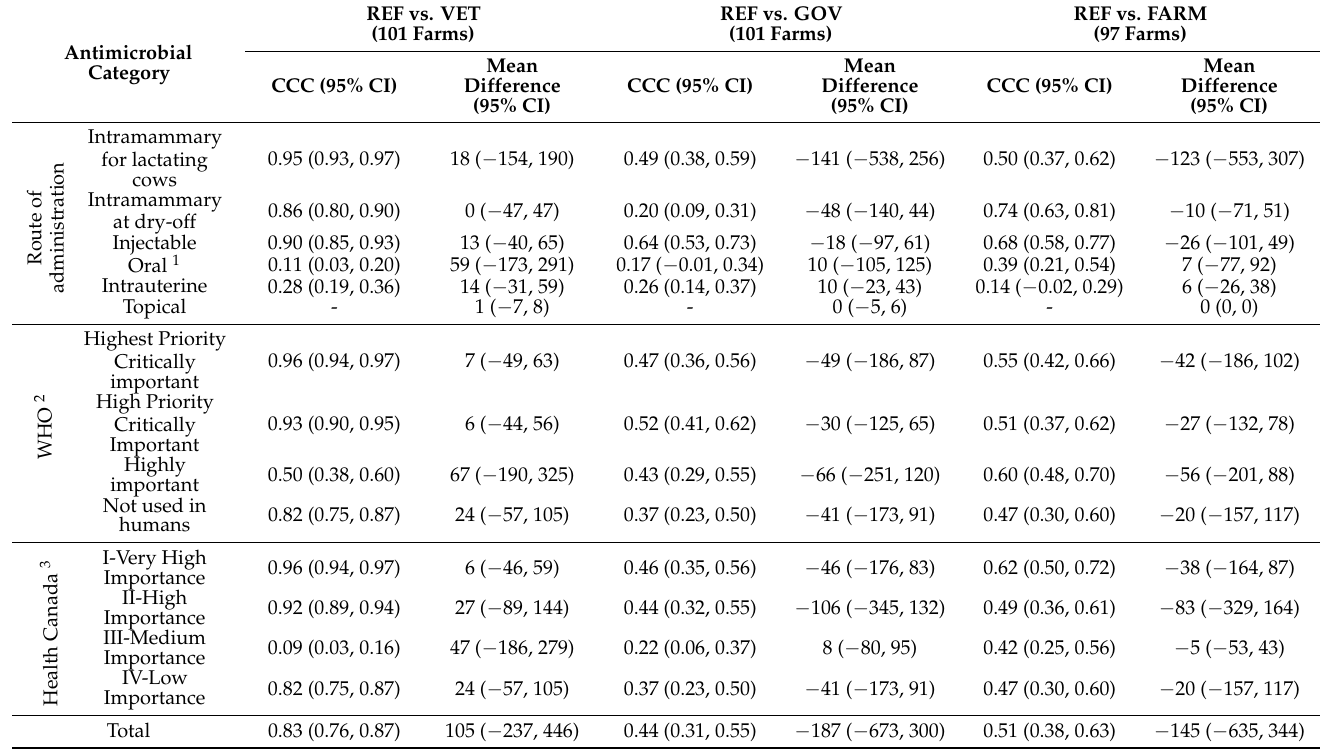
Table 2. Concordance correlation coefficients (CCC) with their 95% confidence interval (95% CI), and mean differences with their 95% CI, calculated from 101 or 97 dairy farms from Qu é bec, Canada, to report agreement between a garbage can audit (REF method) and veterinary invoices (VET method), a governmental database (GOV method), and farm treatment records (FARM method), for quantification of usage rate of antimicrobial agents from products other than medicated feed (in DCDbovCA/100 cow-years) by route of administration, by category according to the World Health Organization (WHO) or to Health Canada, and in